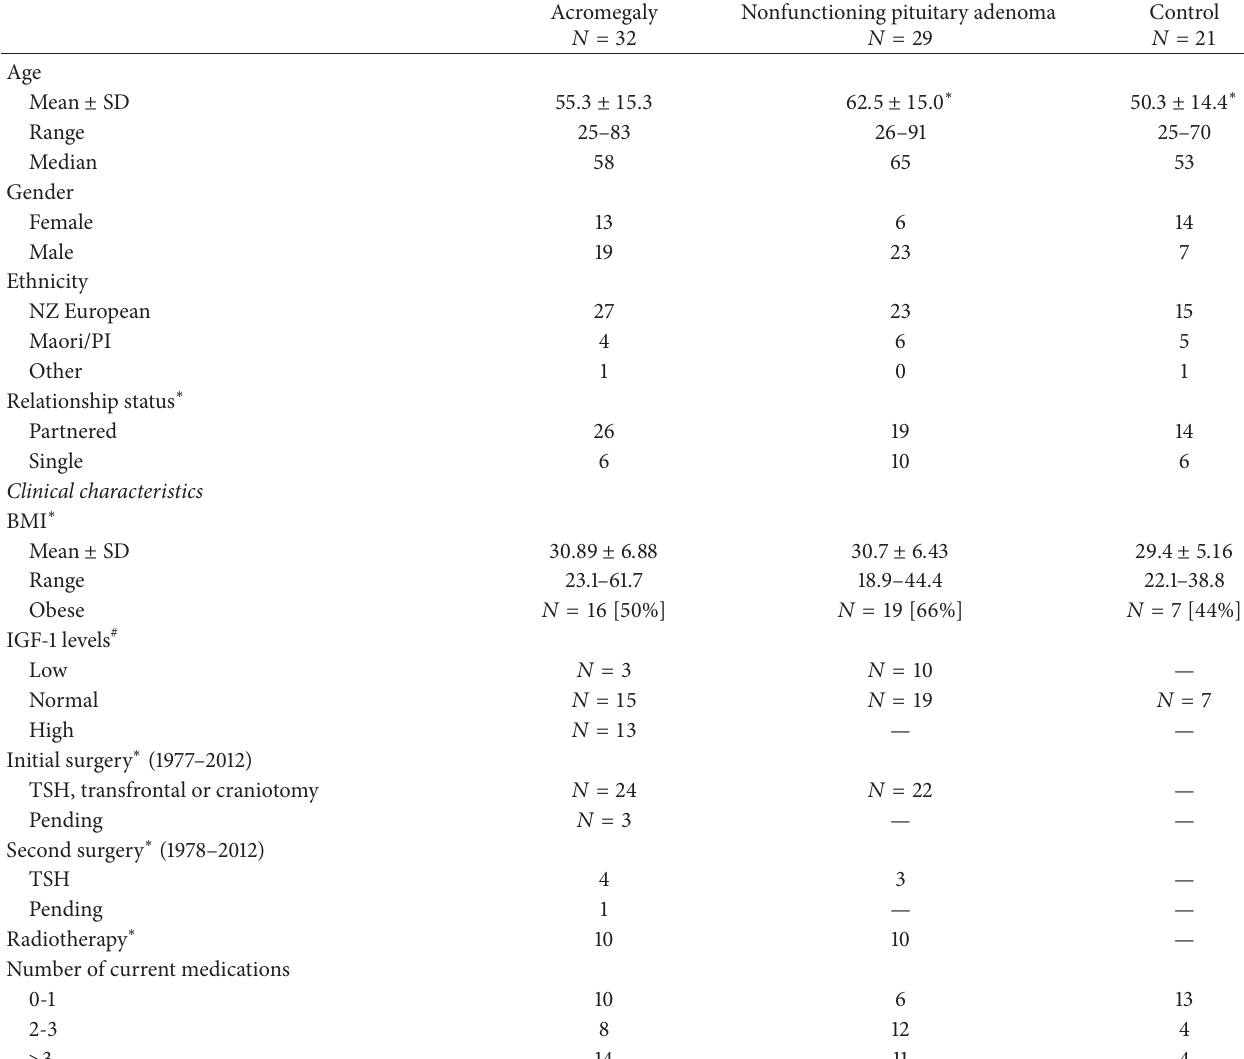
Table 1: Participant demographics and